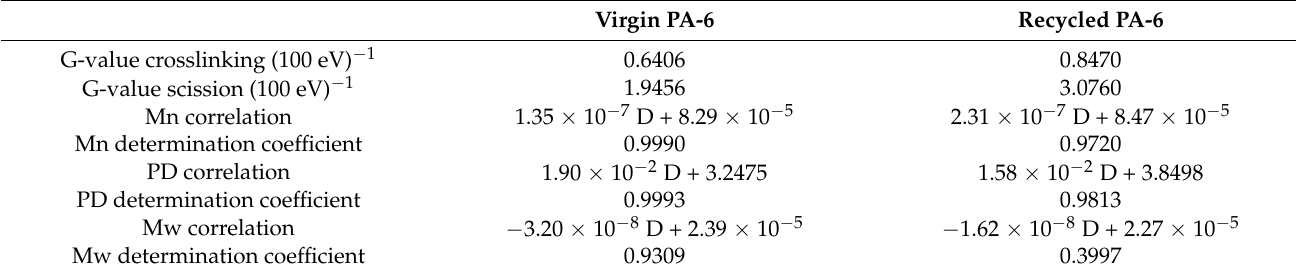
Figure 12. Radiolytic yields for virgin and recycled materials. G-values in (100 eV) -1 . Table 4. Summary of fitting results of GPC data. Table 4. Summary of fitting results of GPC data.